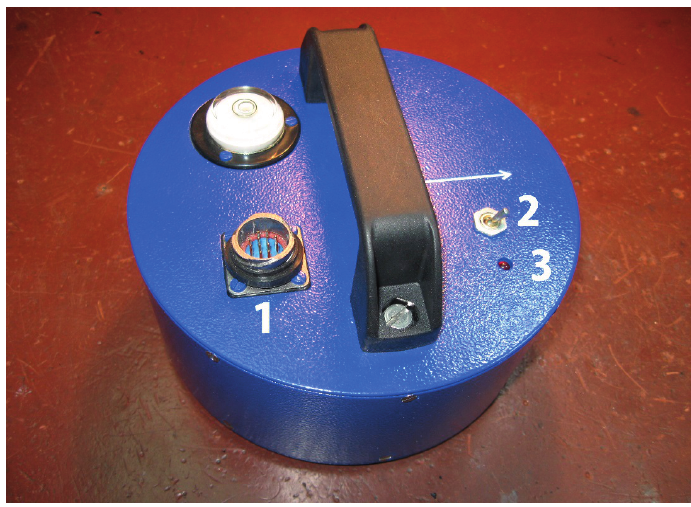
Figure 11. Combined sensor. Marked are output connector (1), MEMS switch (2), MEMS state indicator